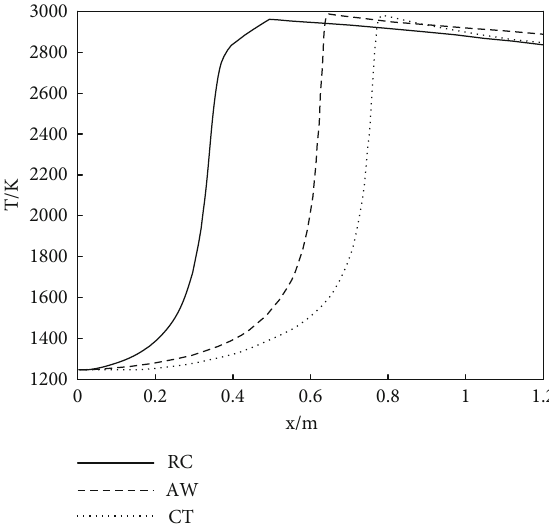
Figure 13: Temperature distributions along the combustor duct.